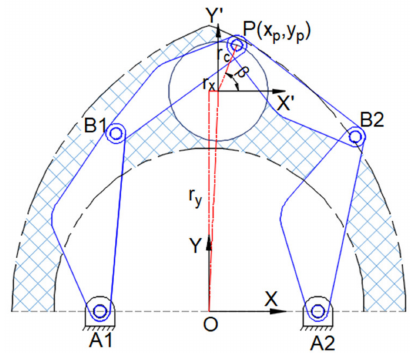
Figure 4. Applied